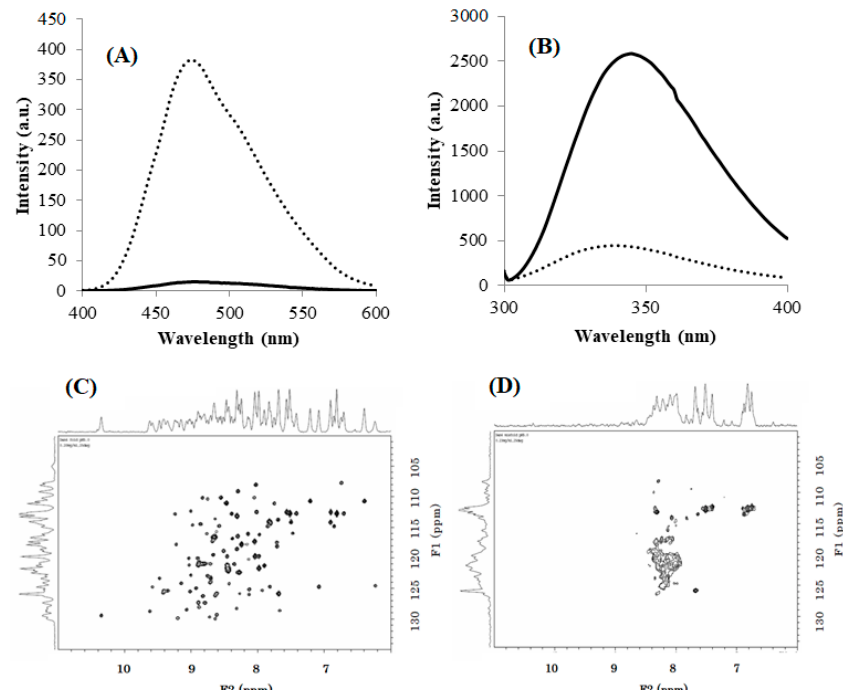
Figure 2. ( A ) 8-Anilinonaphthalene-1-sulfonic acid (ANS) fluorescence spectra and ( B ) Tryptophan fluorescence spectra of DEN4 ED3-1st sup (solid line) and DEN4 ED3-3rd ppt (dotted line) at pH 5.0 and 20 ◦ C ( C ), ( D ): HSQC spectra of 15N-labelled DEN4 ED3-1st sup ( C ) and DEN4 ED3-3rd ppt ( D ) at 0.2 mg / mL, pH 5.0 and 25 ◦ C.